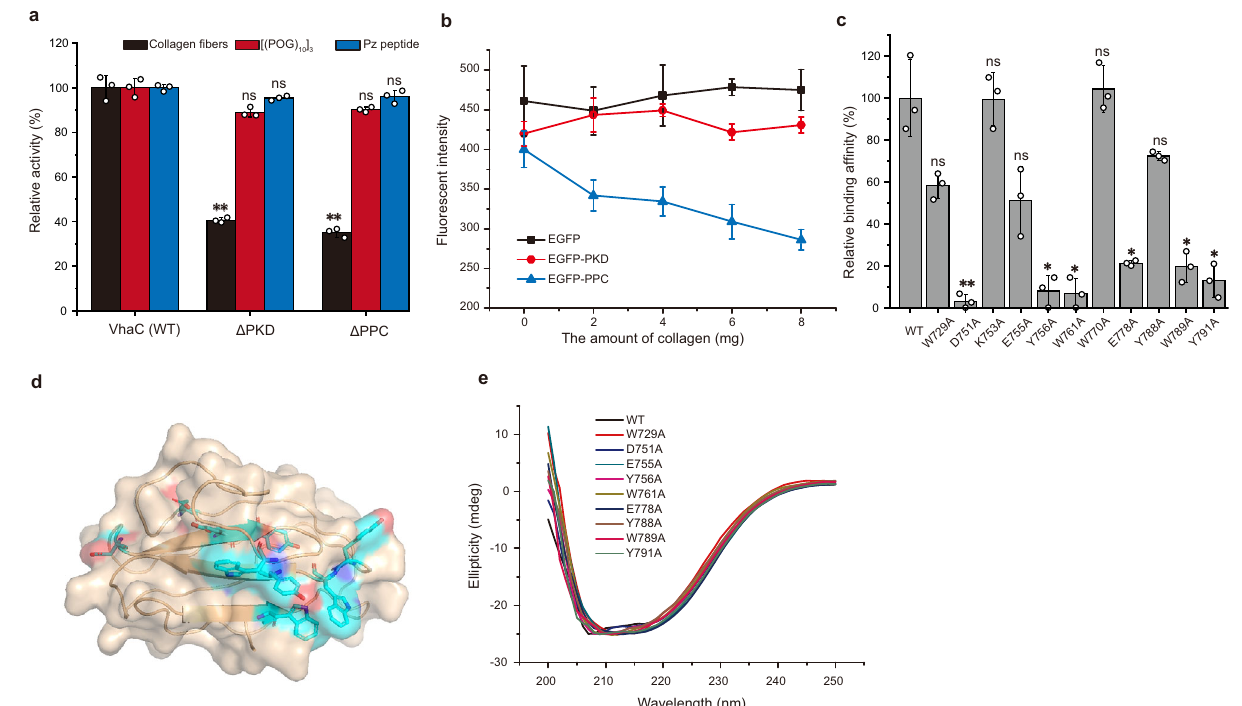
Fig. 4 Functional analysis of the PKD-like and the PPC domains. a The activities of VhaC, Δ PKD, and Δ PPC towards collagen fi bers, [(POG) 10 ] 3 , and Pz peptide. The speci fi c activities of VhaC (WT) towards type I collagen fi bers, [(POG) 10 ] 3 , and Pz peptide were taken as 100%. b Fluorescence analysis of the collagen-binding ability of EGFP, EGFP-PKD, and EGFP-PPC. c The collagen-binding ability of EGFP-PPC (WT) and its mutants. d Surface representation of the interface with collagen in the homology-modeled PPC domain. Residues involved in interacting with collagen are shown as cyan sticks. e CD spectra of EGFP-PPC (WT) and its mutants. The data shown are representatives of triplicate experiments. Data shown in fi gures a – c are means ± SD ( n = 3 independent experiments). For comparison of the statistical differences between two groups, a two-tailed t -test was used in statistical analysis. * p < 0.01. ** p < 0.001. ns, no signi fi cant difference ( P ≥ 0.01). The p -values in all cases were compared with the corresponding wild type, and provided in the source data. Source data are provided as a Source Data fi